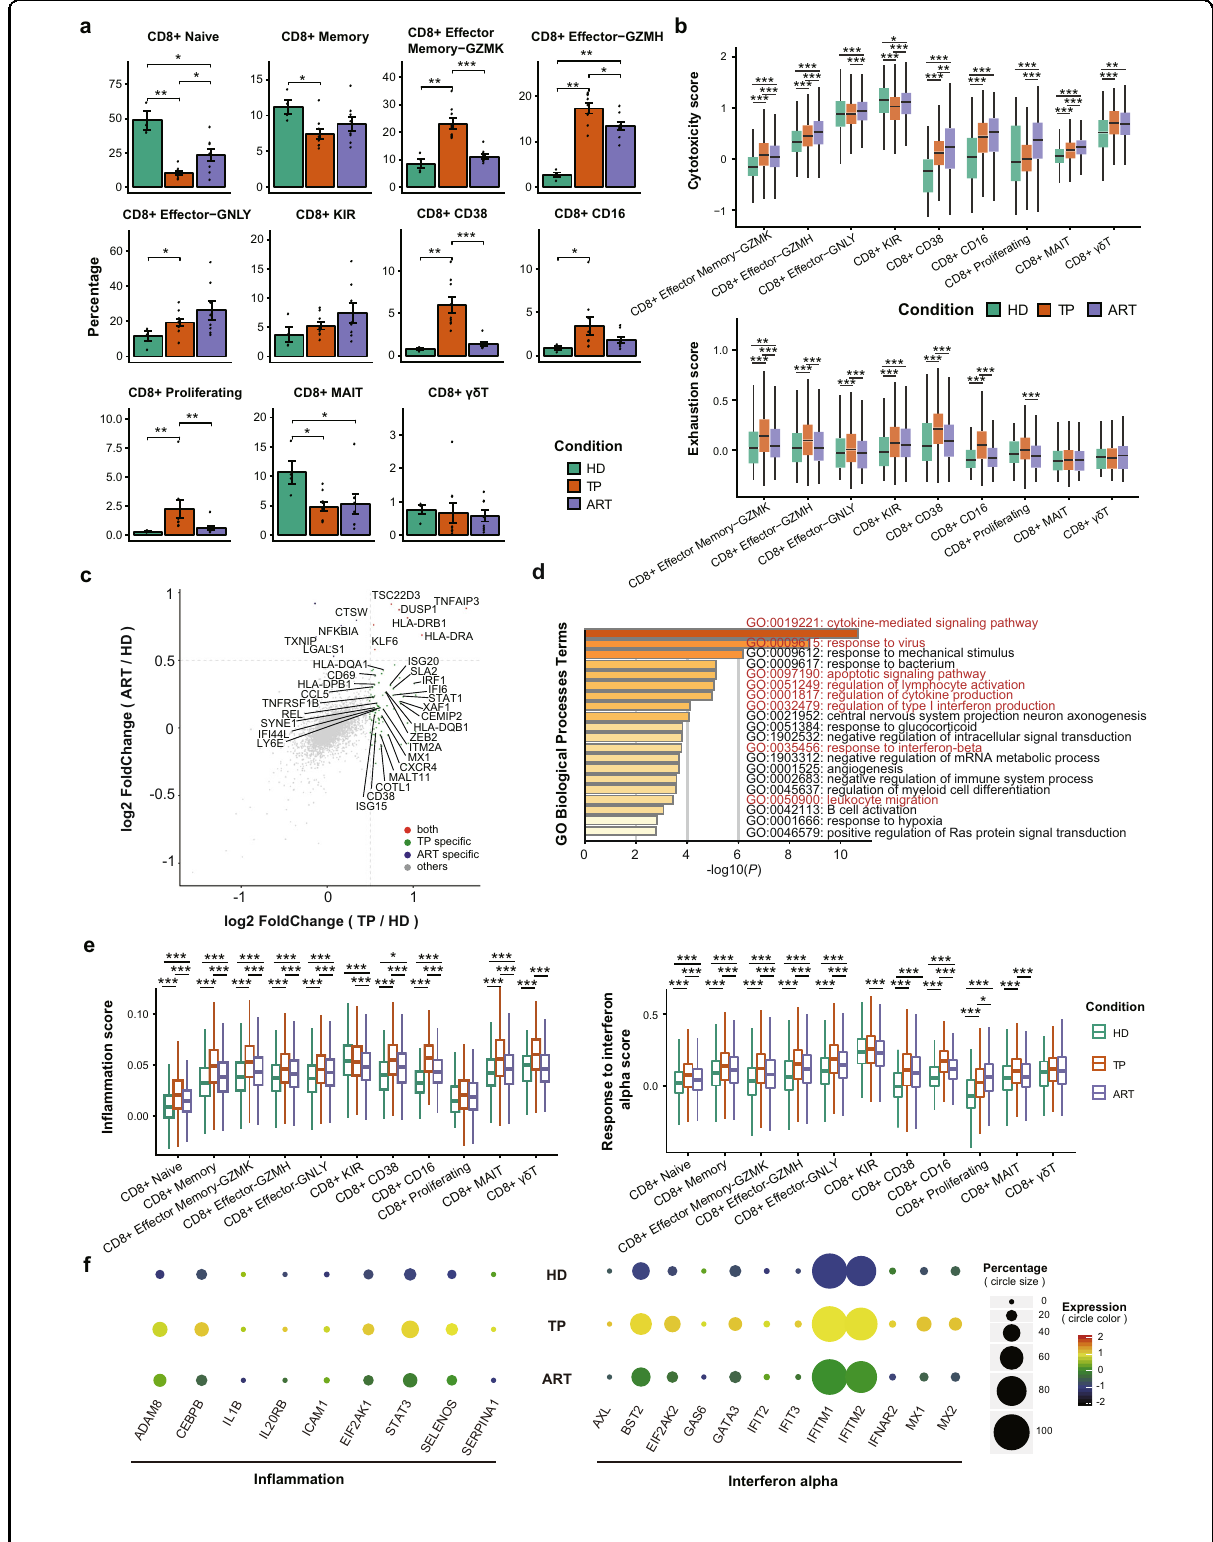
stimulusGO:0009615: response bacteriumGO:0009612: response to mechanical pathwayGO:0009617: response to activationGO:0097190: apoptotic signaling productionGO:0051249: regulation of lymphocyte productionGO:0001817: regulation of cytokine axonogenesisGO:0032479: regulation of type I interferon glucocorticoidGO:0021952: central nervous system projection neuron transductionGO:0051384: response to interferon-betaGO:1902532: negative regulation of intracellular signal processGO:0035456: response to angiogenesisGO:1903312: negative regulation of mRNA metabolic processGO:0001525: differentiationGO:0002683: negative regulation of immune system migrationGO:0045637: regulation of myeloid cell activationGO:0050900: leukocyte transductionGO:0042113: B cell GO:0046579: positive regulation of Ras protein signal